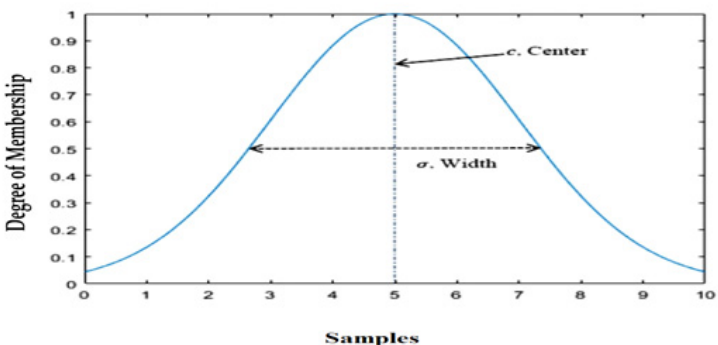
FigureA1. Features of membership function. Figure A1. Features of membership